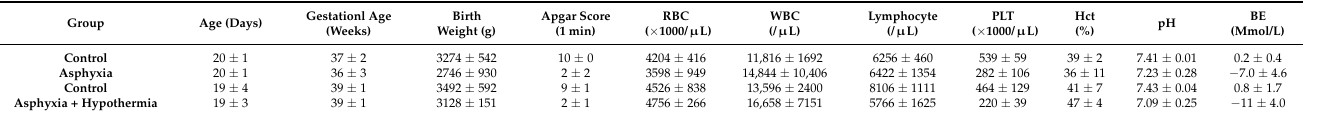
Table 1. Clinical characteristics of enrolled